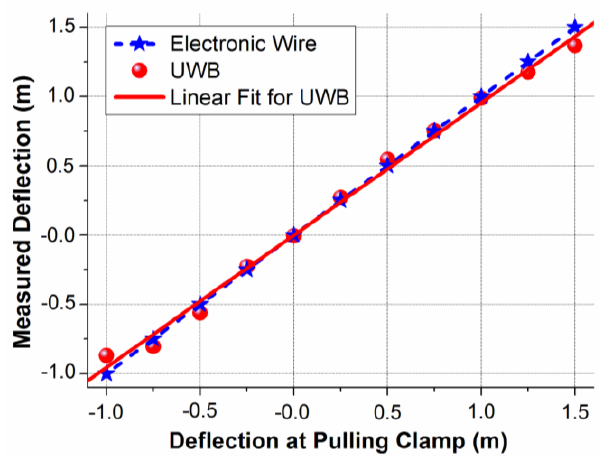
Figure 9. Comparison of the UWB and electronic wire deflection